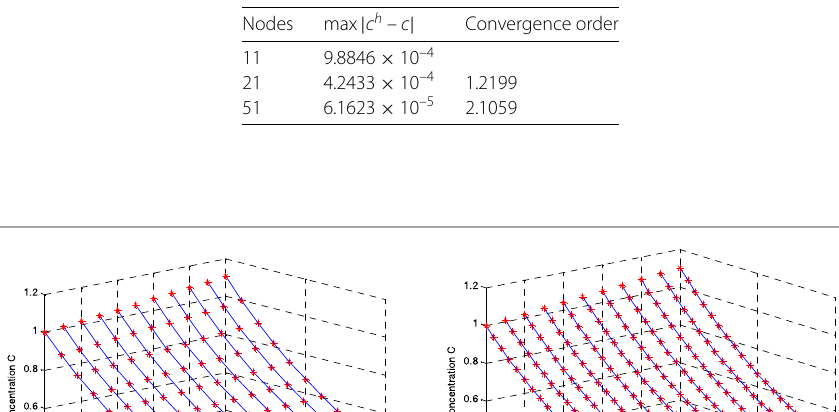
Table 6 The convergence order of the UFPM with T = 1 time steps when (cid:11) t =